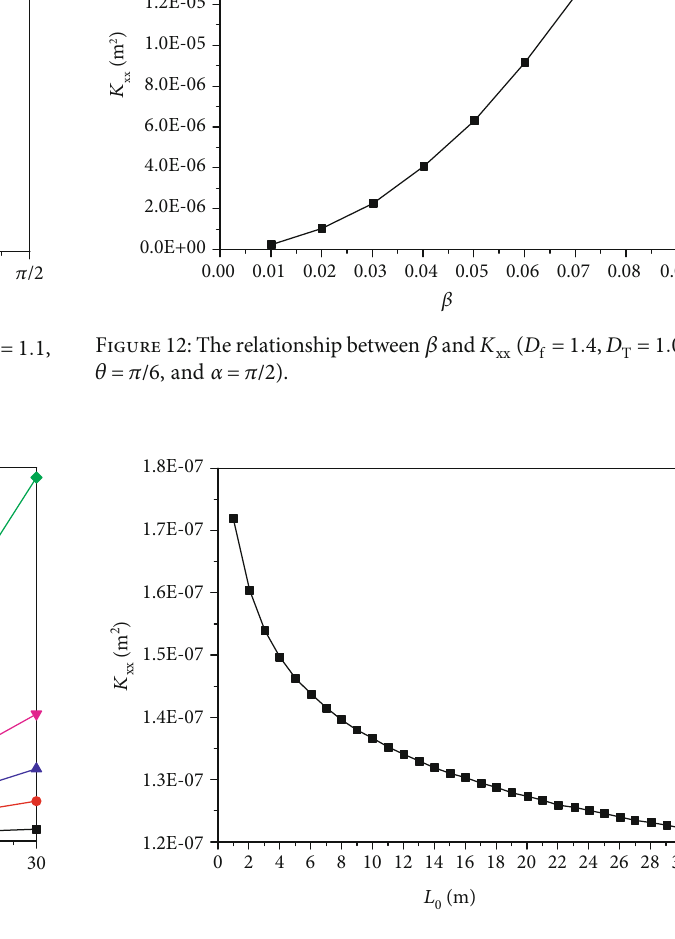
and K ( D = 1 : 4 , D = 1 : 1 , 0 xx f T